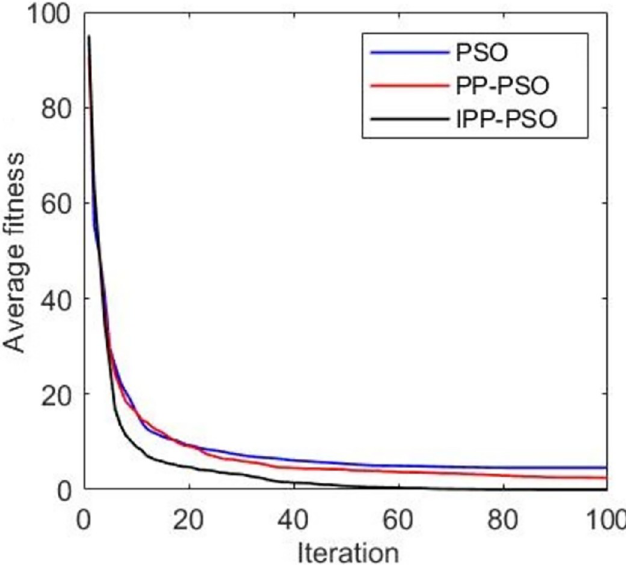
Fig 6. The average fitness function value of two—person zero—sum game simulation results.